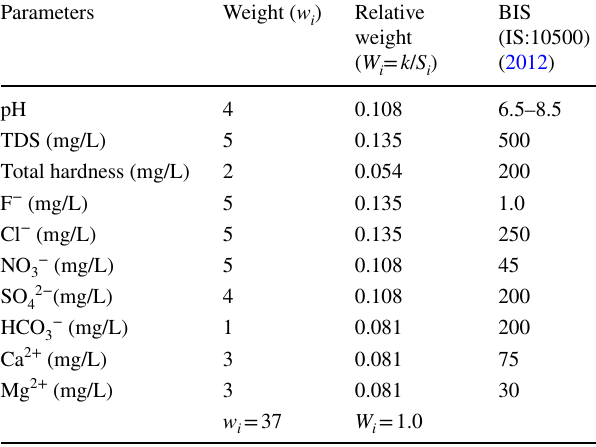
Table 1 Relative weight of chemical parameters Parameters